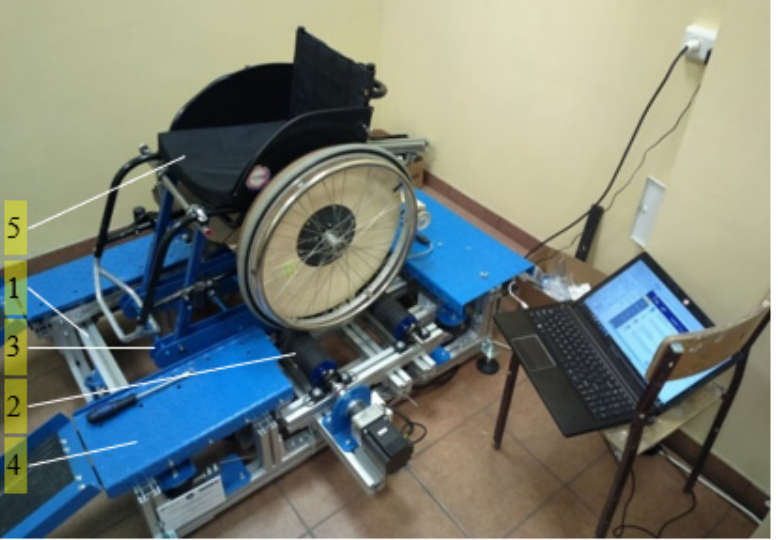
Figure 4. Bench with the prototype wheelchair: 1—bench frame; 2—resistance rollers; 3—anchorage mechanism for the tested wheelchair; 4—ramp, and 5—tested wheelchair.